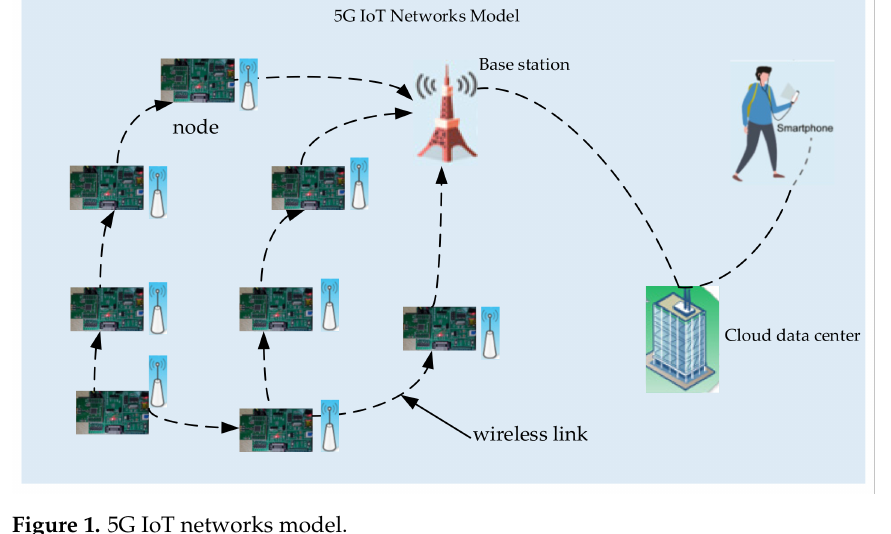
Figure 1. 5G IoT networks